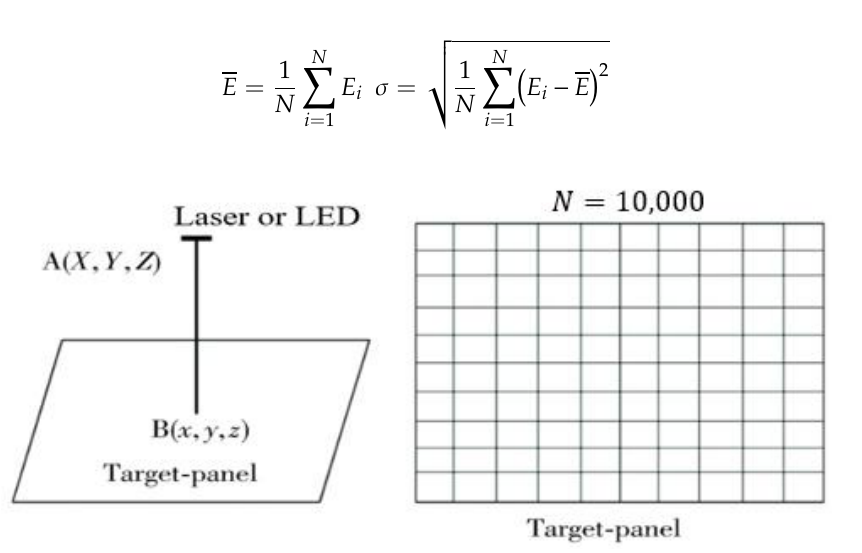
Figure 3. Laser and LED lighting model.